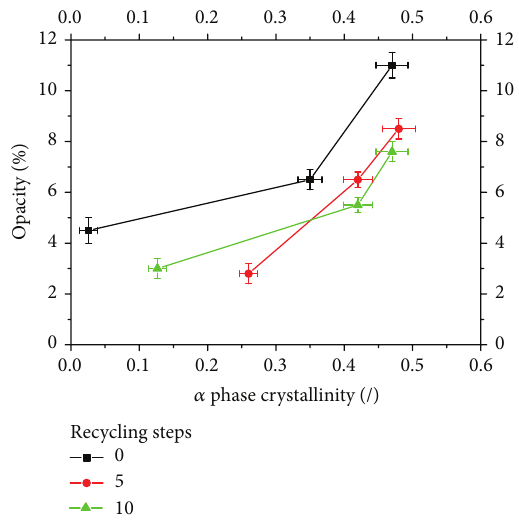
Figure 8: Opacity versus the amount of 𝛼 phase inside each sample.